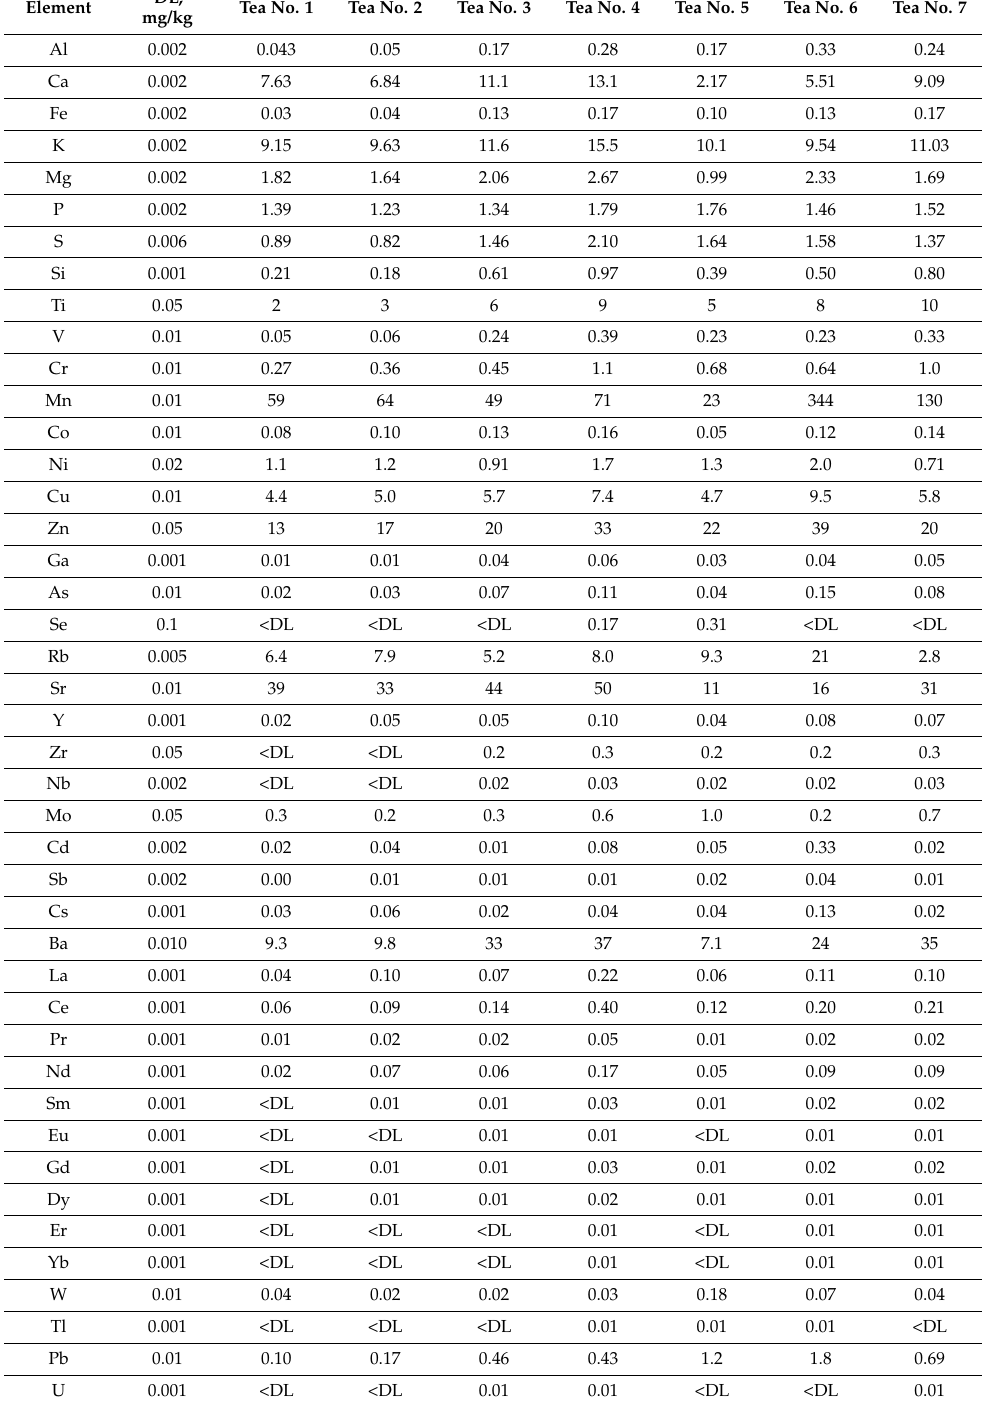
Table 4. Results of ICP-AES (Al-Si) and ICP-MS analyses of herbal blends by the Bionarium Scientific and Production Center, Vladikavkaz (content of Al, Ca, Fe, K, Mg, P, S and Si in mg/g and for the rest of the elements–in µ